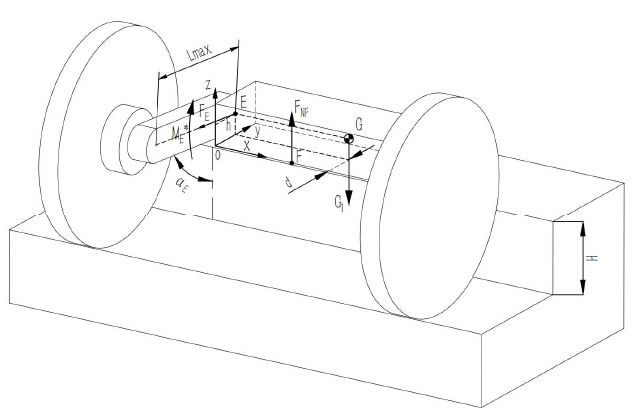
Figure 7. A simplified model of the mechanics in the case of the robot overturning. The tensile force of the telescopic cantilever on the frame is F E , the supporting force of stair tread on the frame is F NF , the action point is F (i.e., 0, Y F and Z F ), the centroid of the frame is G (i.e., x G , y G and z G ), and the gravity is G 1 . The output torque of the motor is M E * .